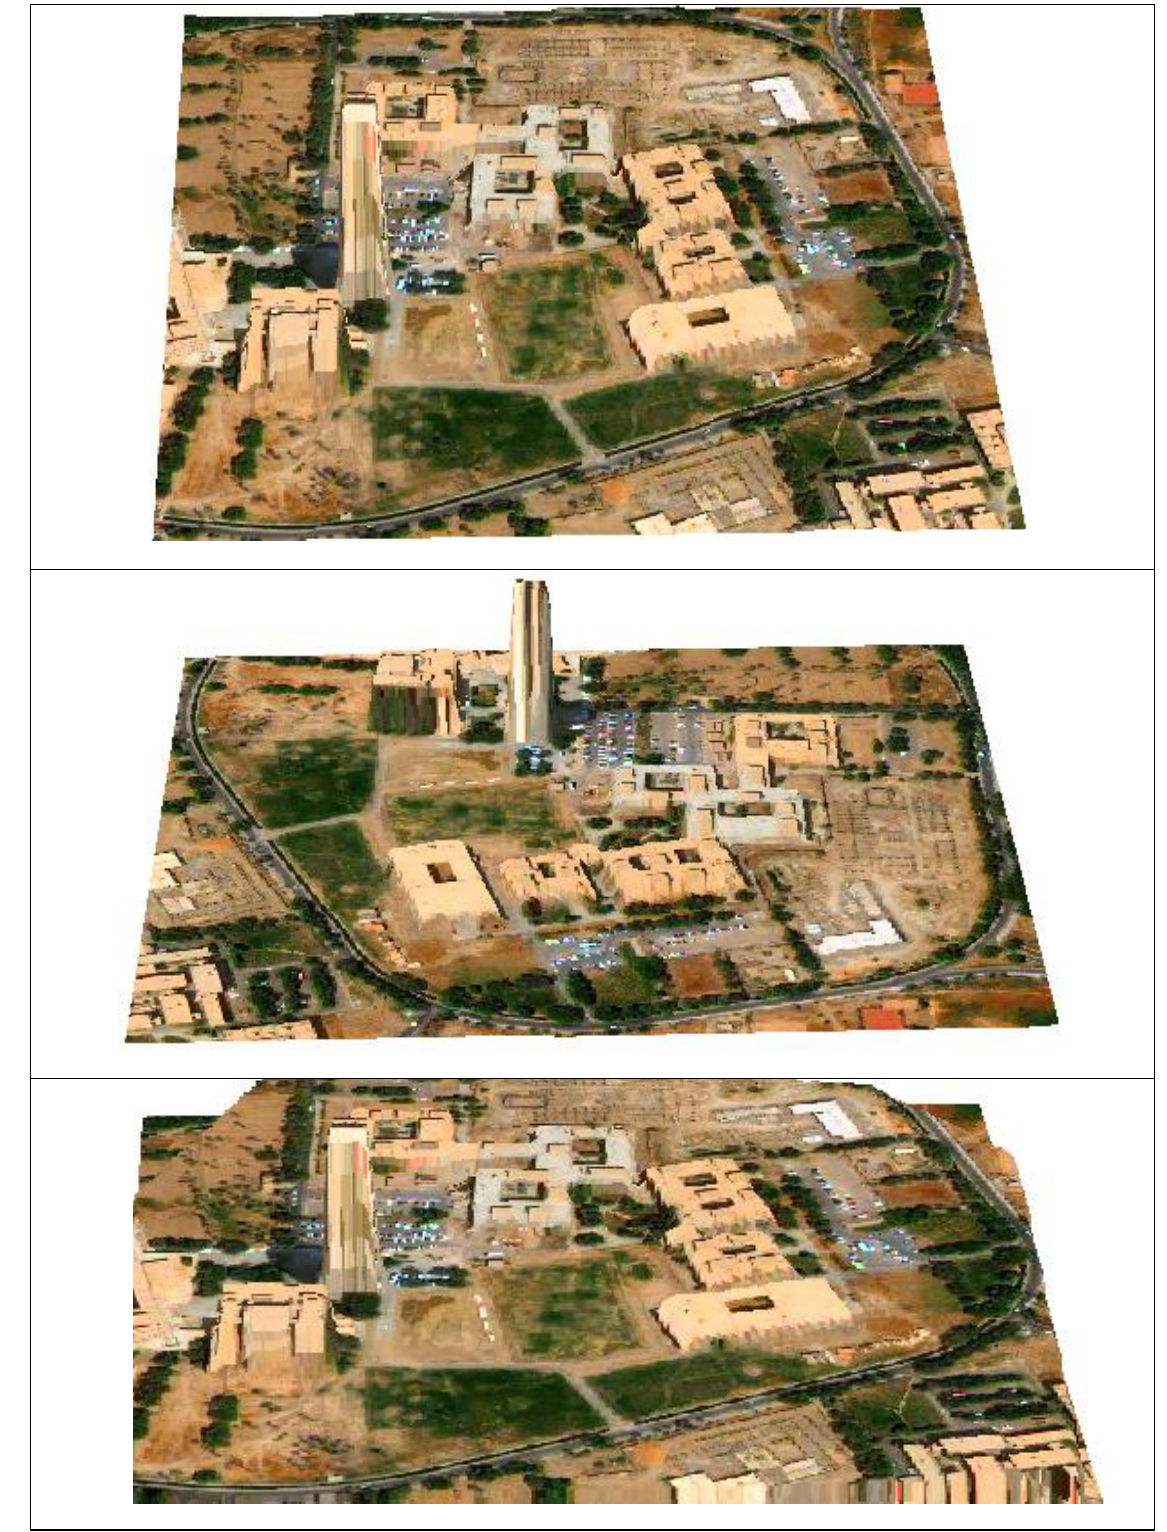
Fig. 10: Illustrating the generation of 3D view by projecting the image of the studied area on the layers it’s DEM in different